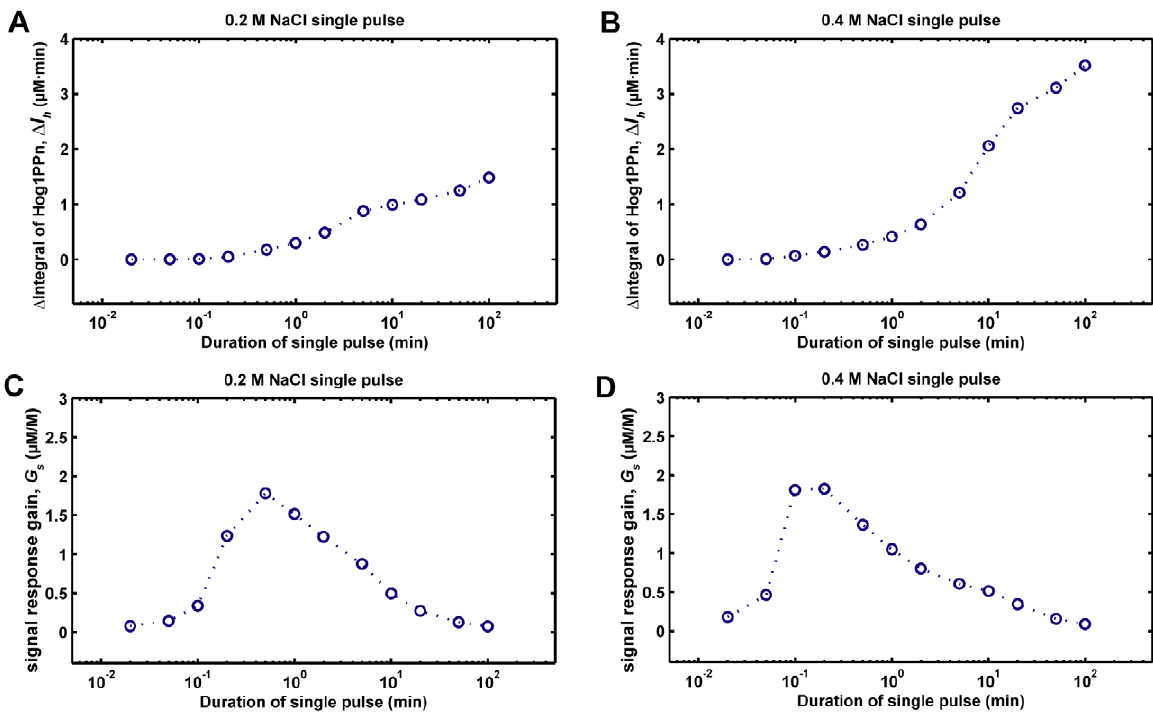
Figure 7. Relationship between nuclear phosphorylated Hog1 (Hog1PPn) response and the duration of single pulses of NaCl change. D I h : integral change of Hog1PPn response. G s : Hog1PPn response gain.